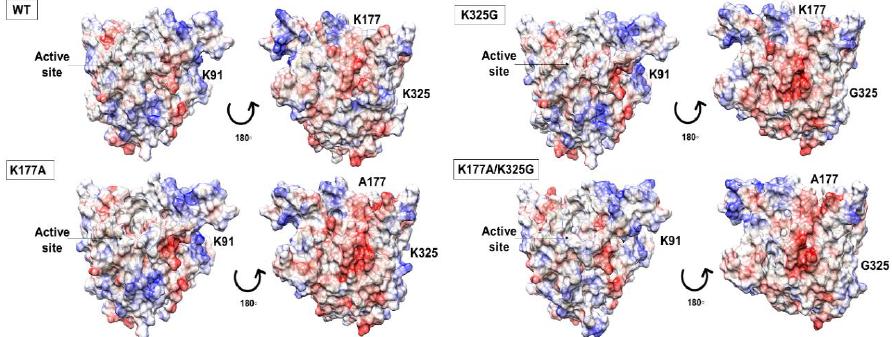
Figure 2. Electrostatic potential maps displayed on the surface of WT, mutant K177A, K325G, and K177A/K325G. The red colour indicated negatively charged region, positively charge region as blue and white colour defining neutral part of each lipase. The active site is circled and showed by arrow.